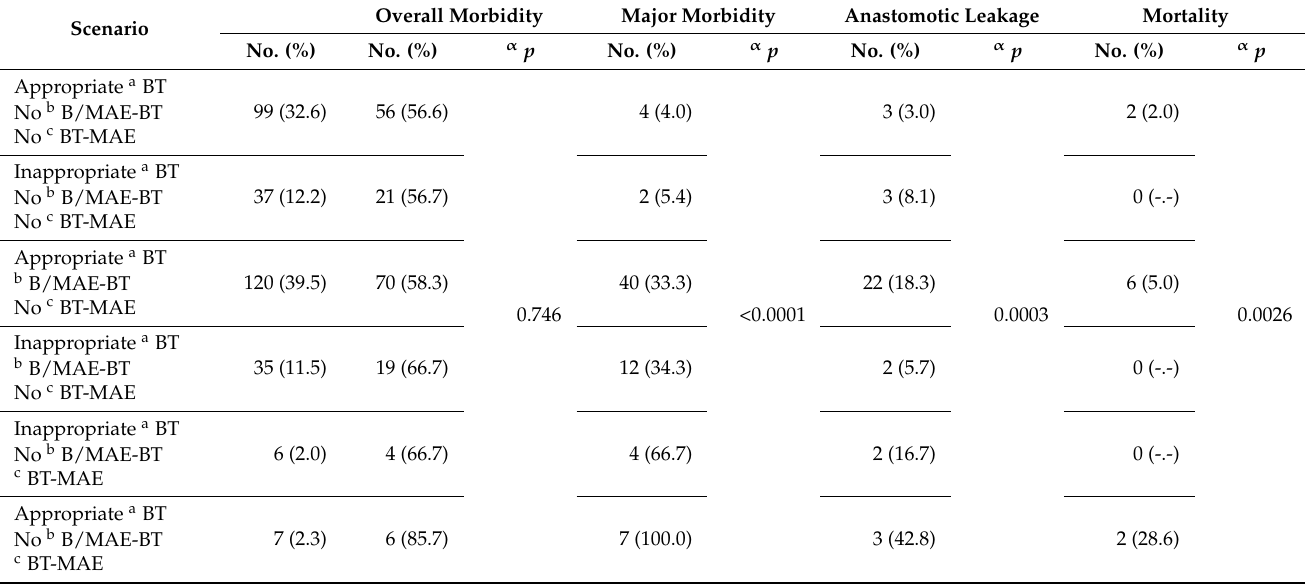
Table 6. Matching scenarios of BT